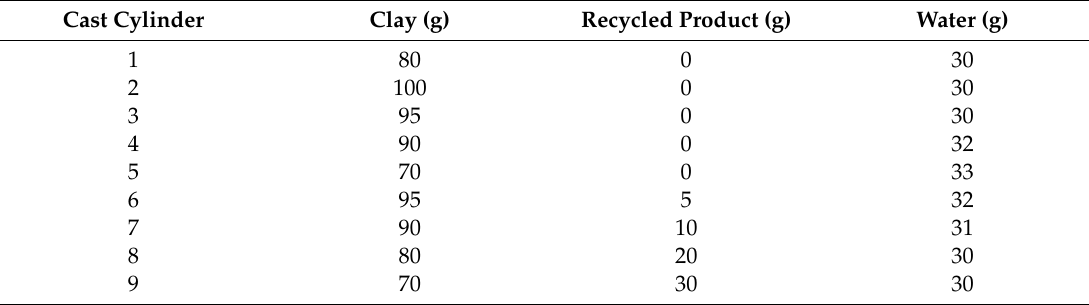
Table 4. Samples prepared to the thermal